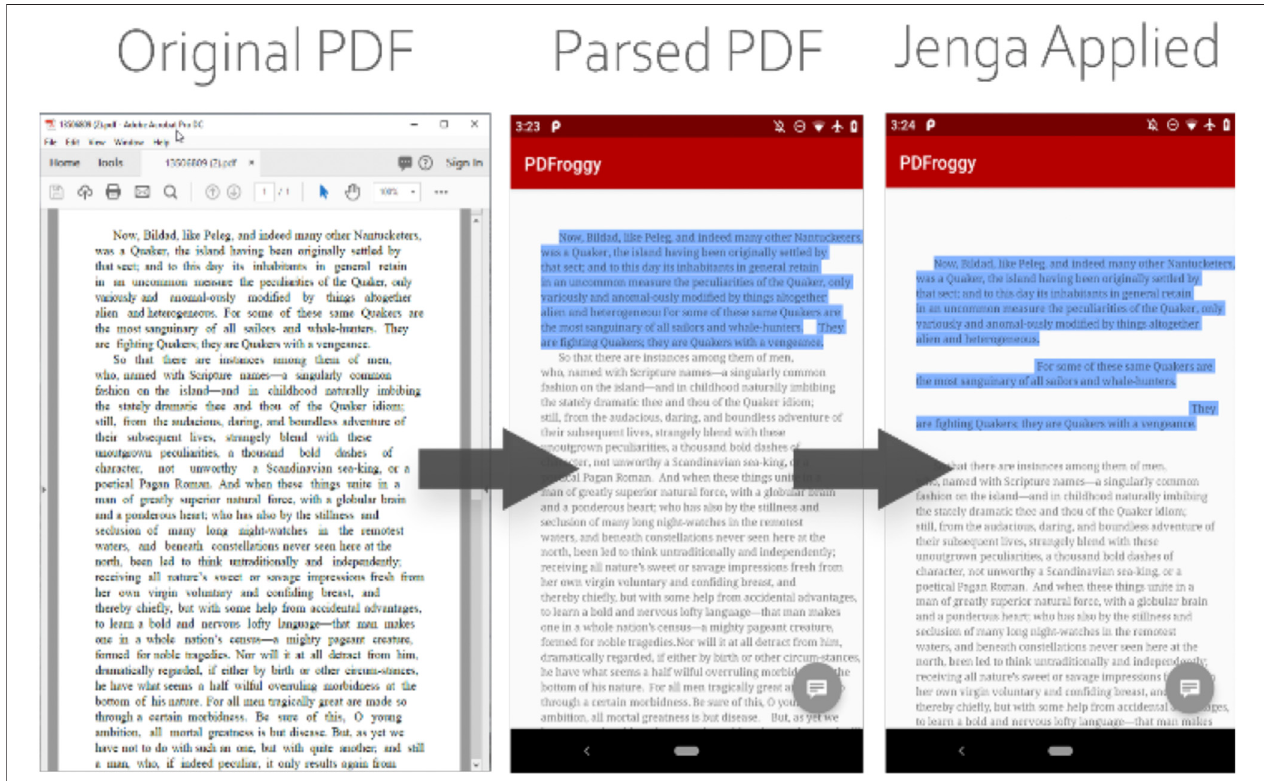
FIGURE 4 | PDFroggy — The execution results of applying Jenga transformation to a PDF fi